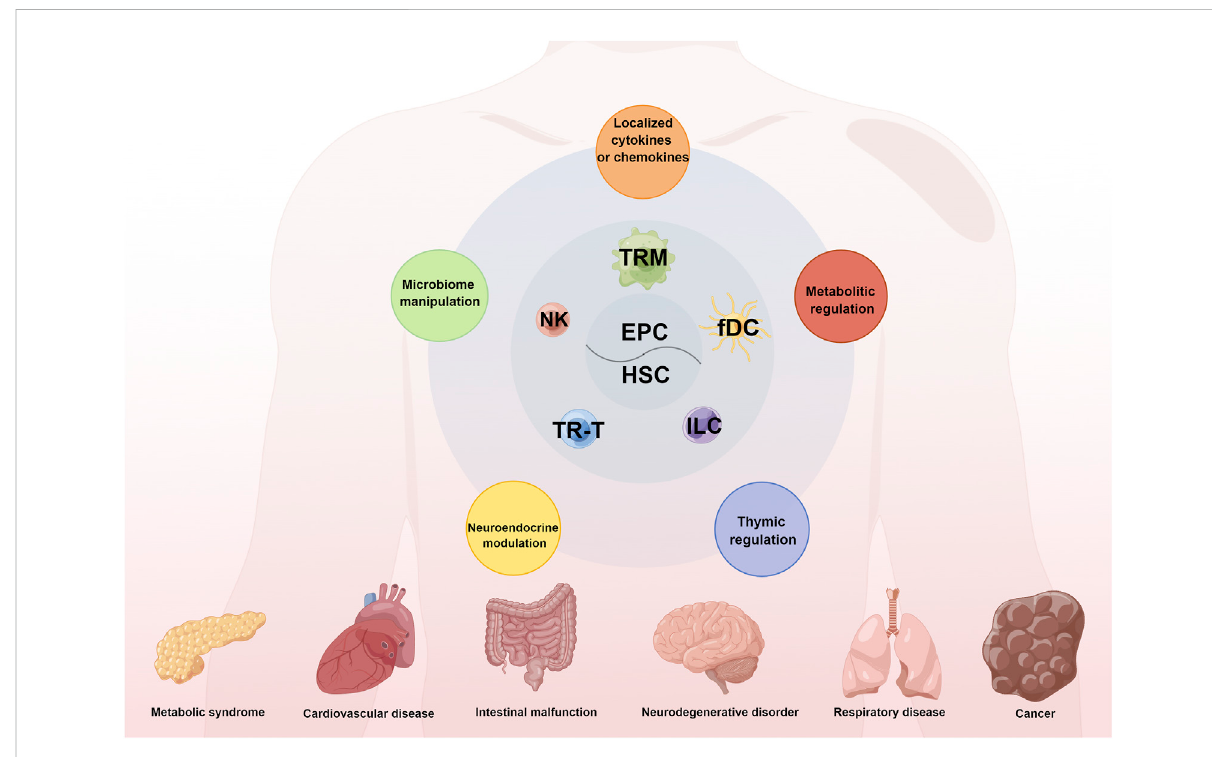
FIGURE 1 The origins, compositions, and functions of TRICs in human diseases. Tissue-resident immune cells (TRICs) mainly originate from embryonic progenitor cells (HSC) or adult haematopoietic stem cell (HSC). And TRICs mainly consist of diverse tissue-resident macrophages (TRM), NK cell, tissue-resident T (TR-T) lymphocytes, innate lymphoid cells (ILC) and follicular dendritic cells (fDC). TRICs have a vital effect on various human diseases like metabolic syndrome, cardiovascular disease and cancer through the integrated mechanisms including metabolic regulation, thymic regulation, neuroendocrine modulation, microbiome manipulation and secretion of cytokines and